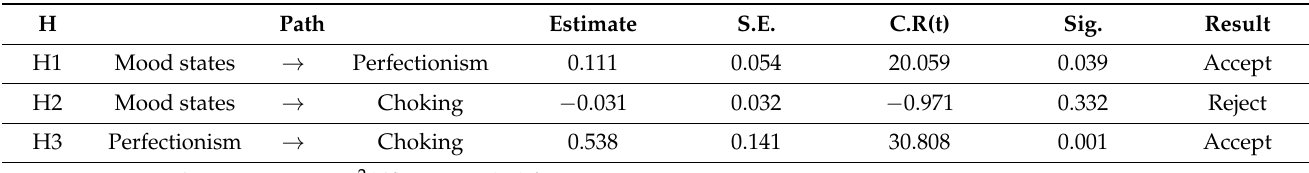
Table 5. Path analysis and fit index of the research